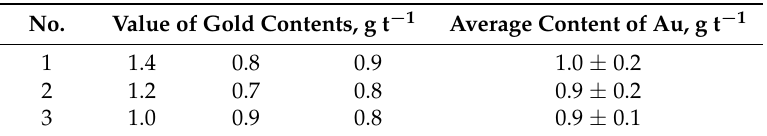
Table 5. Results of determining the gold in solutions after precipitation of gold(III) ions from pyrite of the Kirovsko–Kryklinskaya ore zone ( n = 3, P =